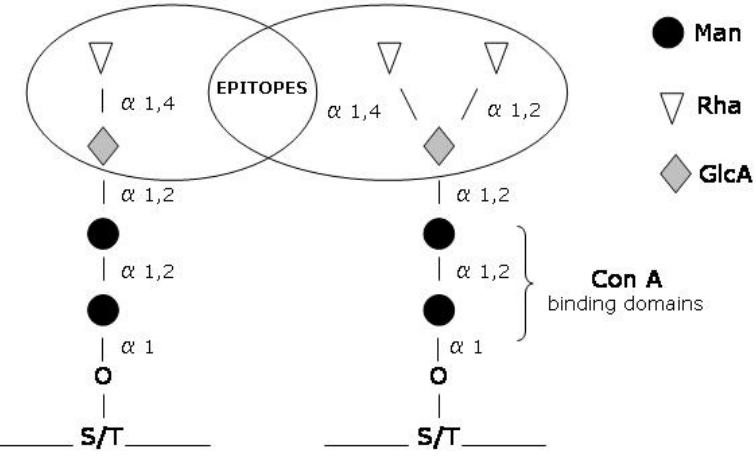
Fig. 1 – Structure of O-glycosidic-linked tetra- and pentasaccharides of S. schenckii cell wall peptido-rhamnomannans showing the main epitopes and the Con A binding residues (adapted from Lopes-Alves et al.